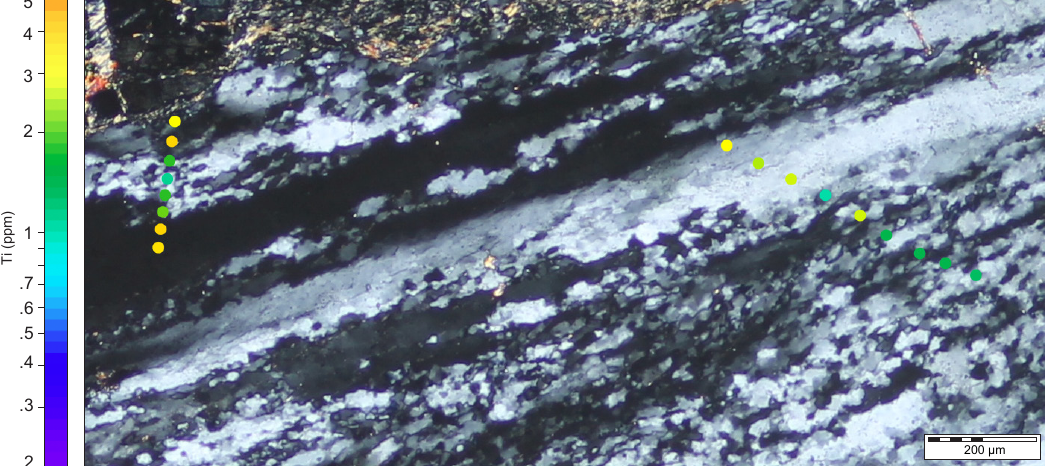
Figure 3. Cross polarized image showing dynamically recrystallized quartz in an ultramylonite sample (77912). Large ribbon grains, showing undulose extinction and subgrains, are interpreted as remnants, predating ultramylonite deformation. Recrystallized zones contain small, more equant grains with relatively uniform extinction. Typical of samples found within ∼ 150m of the Alpine Fault, lower Ti concentrations (green dots) are found in recrystallized zones than in the ribbon grains (yellow and orange